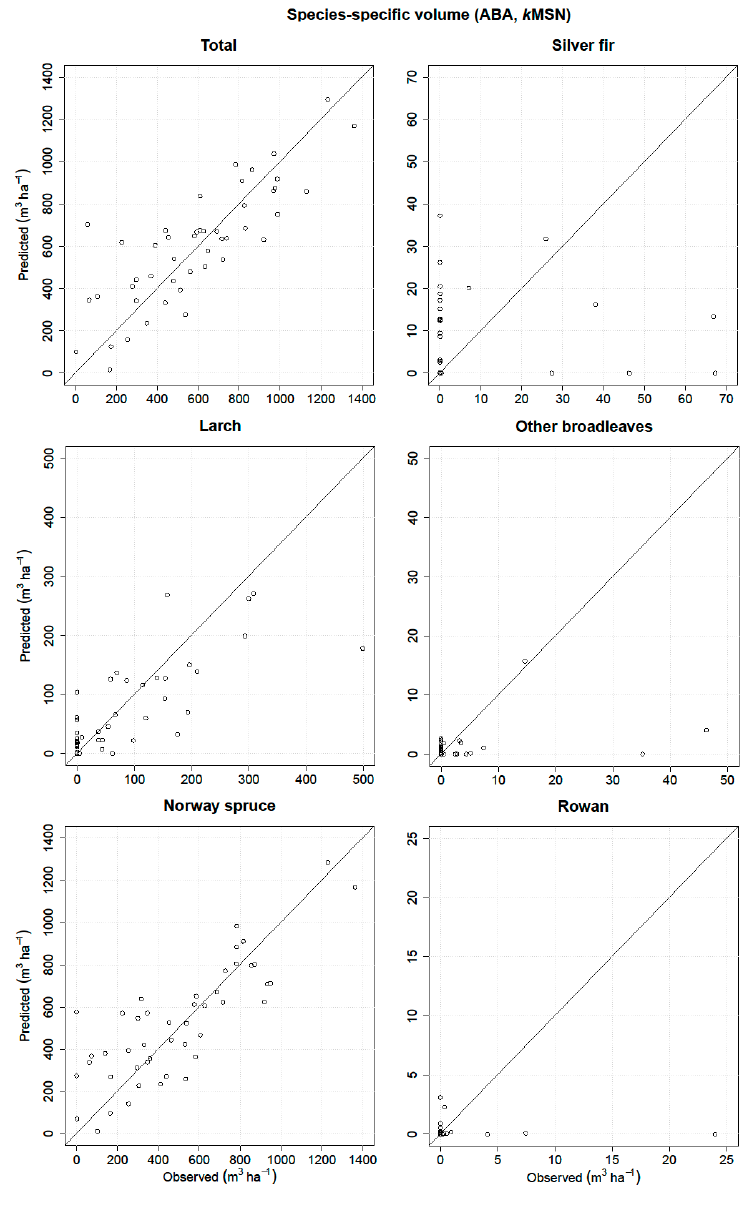
Figure 5. Observed versus predicted species-specific volumes at the plot level derived from the area based approach (ABA) method. Table 6. Results of the predicted volumes using the k-nearest neighbor approach derived from ABA at the plot